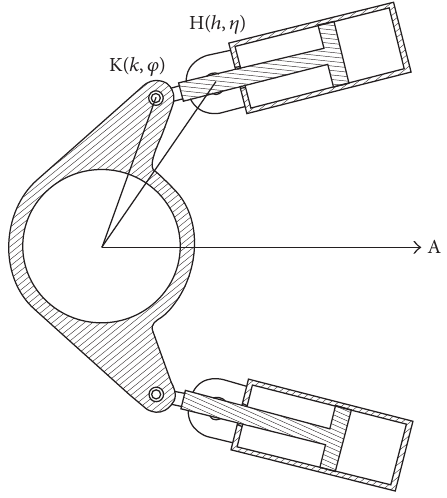
Figure 4: Simplified model